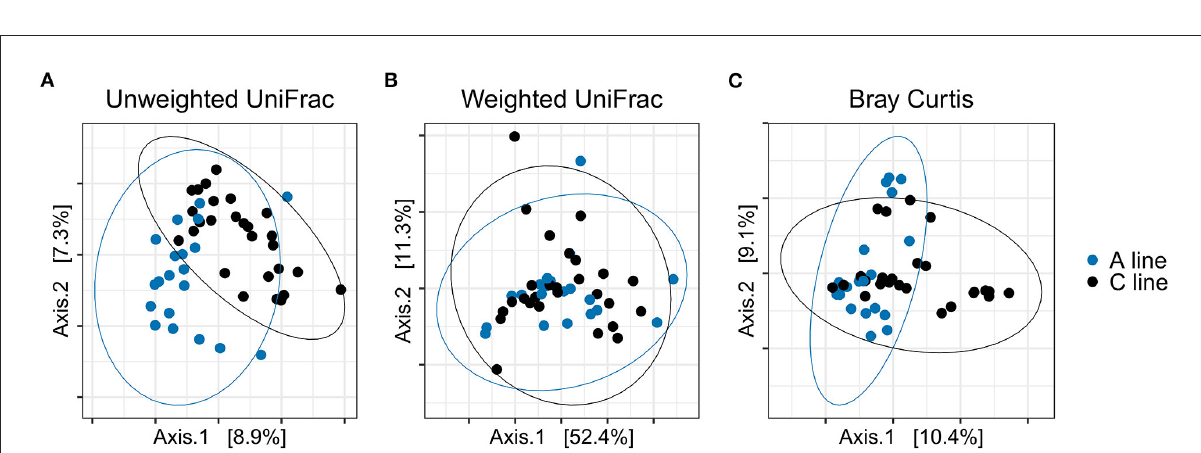
FIGURE7 PCoA plots of bacterial community composition of the gut microbiotas from the offspring bank voles reared in field conditions (blue, A line; black, C line). (A) Unweighted UniFrac, (B) Weighted UniFrac, (C) Bray–Curtis dissimilarity. Dots represent individual samples and ellipses indicate 95% confidence